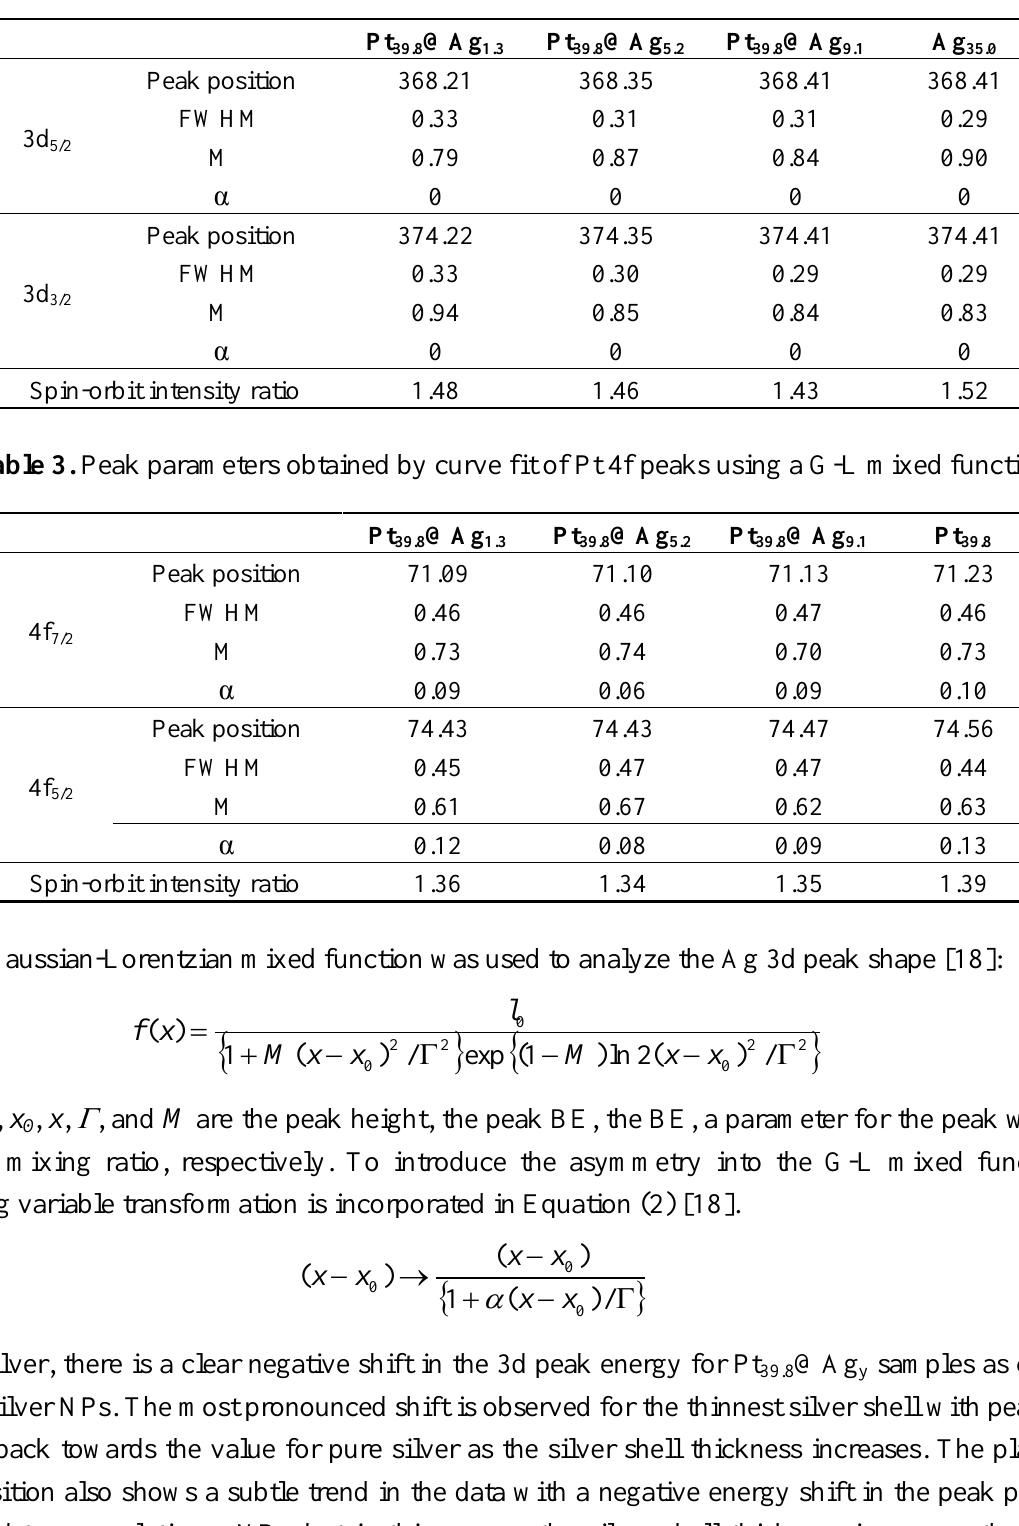
Table 2. Peak parameters obtained by curve fit of Ag 3d peaks using a G-L mixed function.